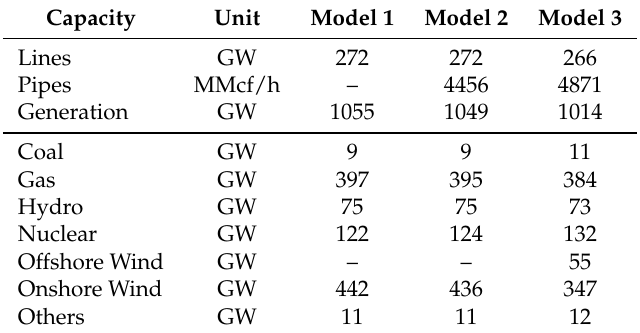
Table 6. Final capacity comparison.